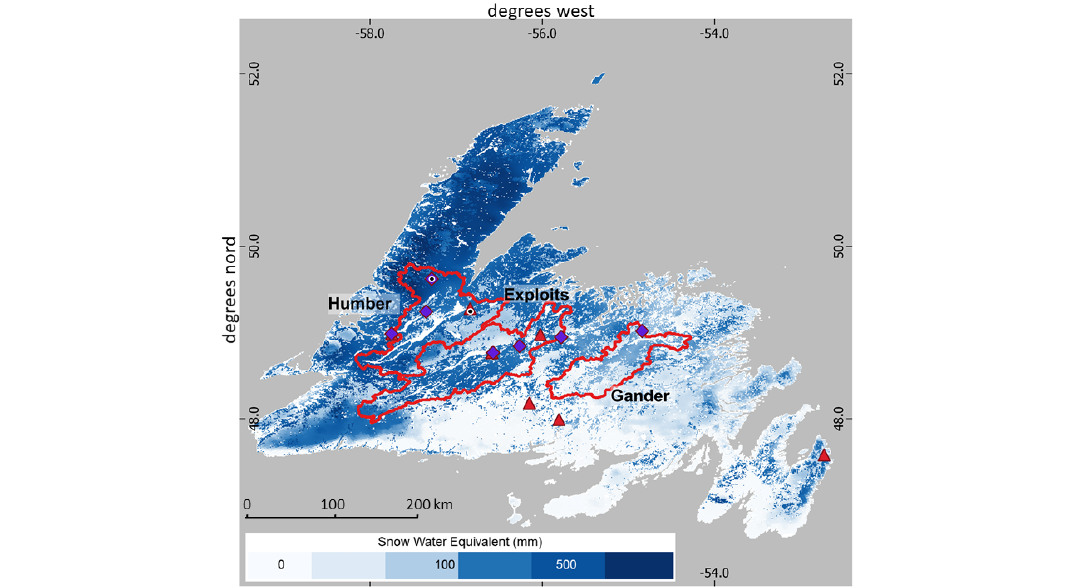
Figure 2. Overview on locations of SnowSense in situ stations (red triangles) and run-off stations (purple diamonds), within the Humber, Exploits, and Gander catchments in Newfoundland, Canada. Catchments are outlined with a red line. The locations of the two existing snow water equvalent (SWE) stations are indicated as black dots. The background shows the modelled SWE, which was assimilated by in situ stations and Earth Observation (EO) for the 15 March